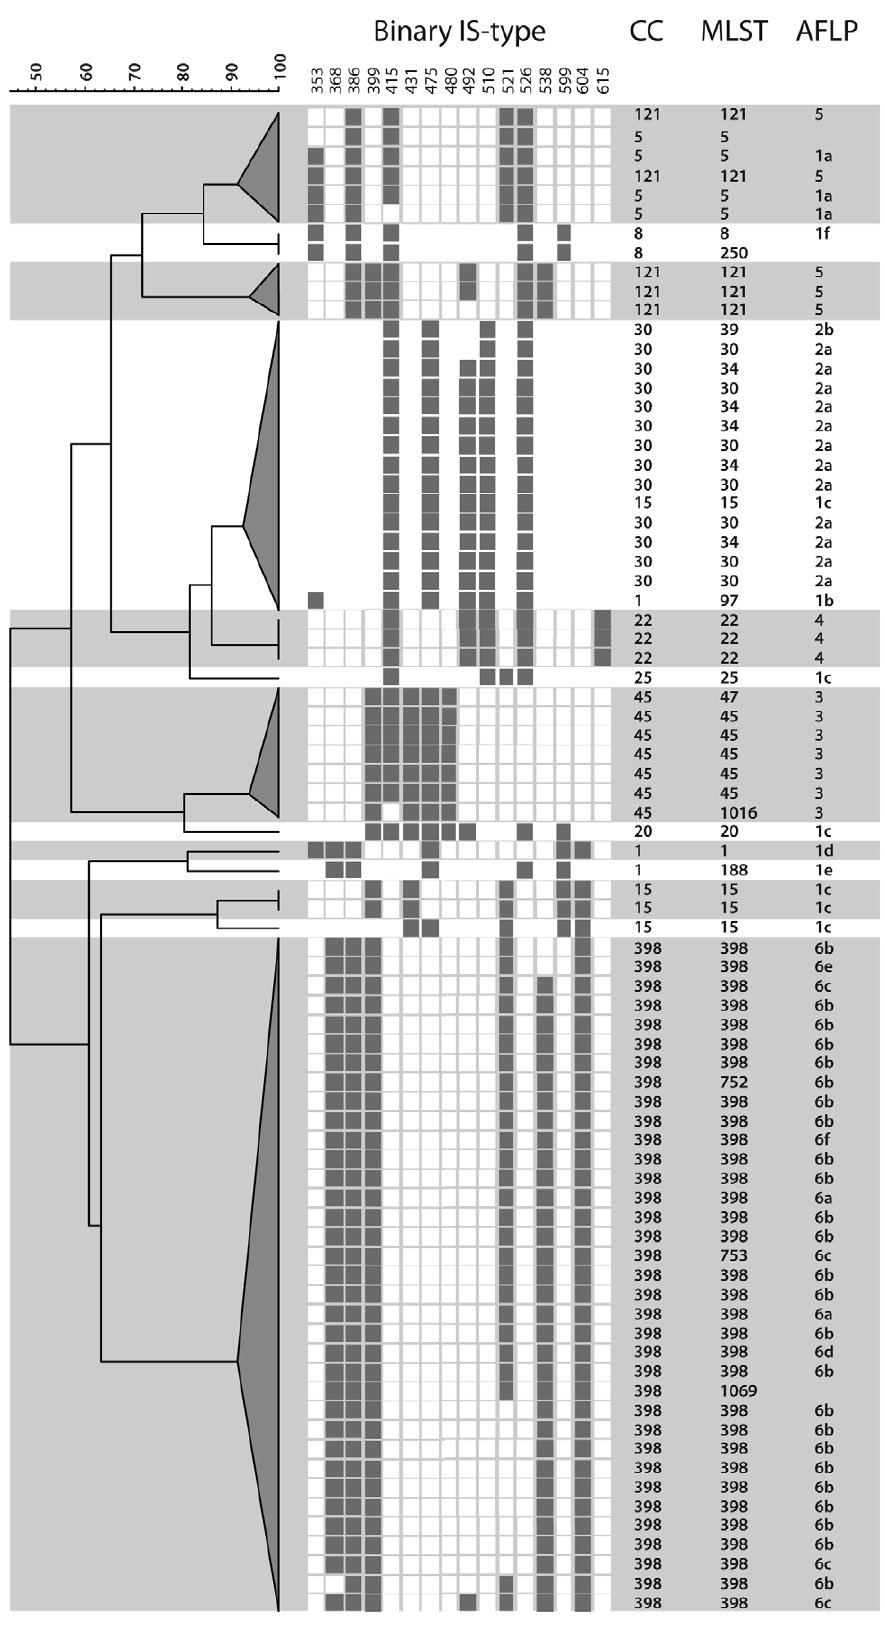
Figure 2. Correlation of digital IS profiles with MLST and AFLP. Thirty-three unique IS types were found belonging to 13 clusters. These clusters were defined as strains with identical binary profiles (connected by a vertical line) or as profiles differing no more than one digit from the most common profile within that group (connected by grey triangles).